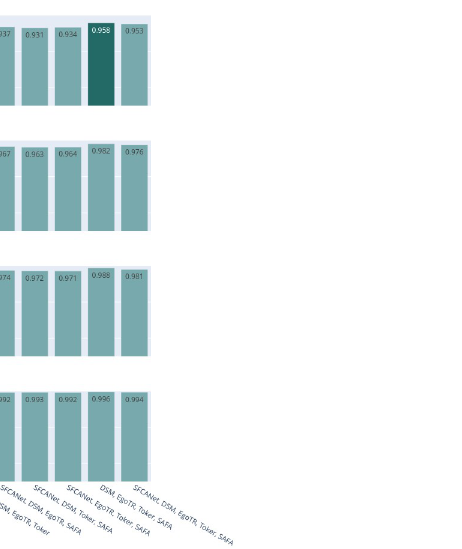
Fig 12. CVUSA combinations for hard-voting with the random selection